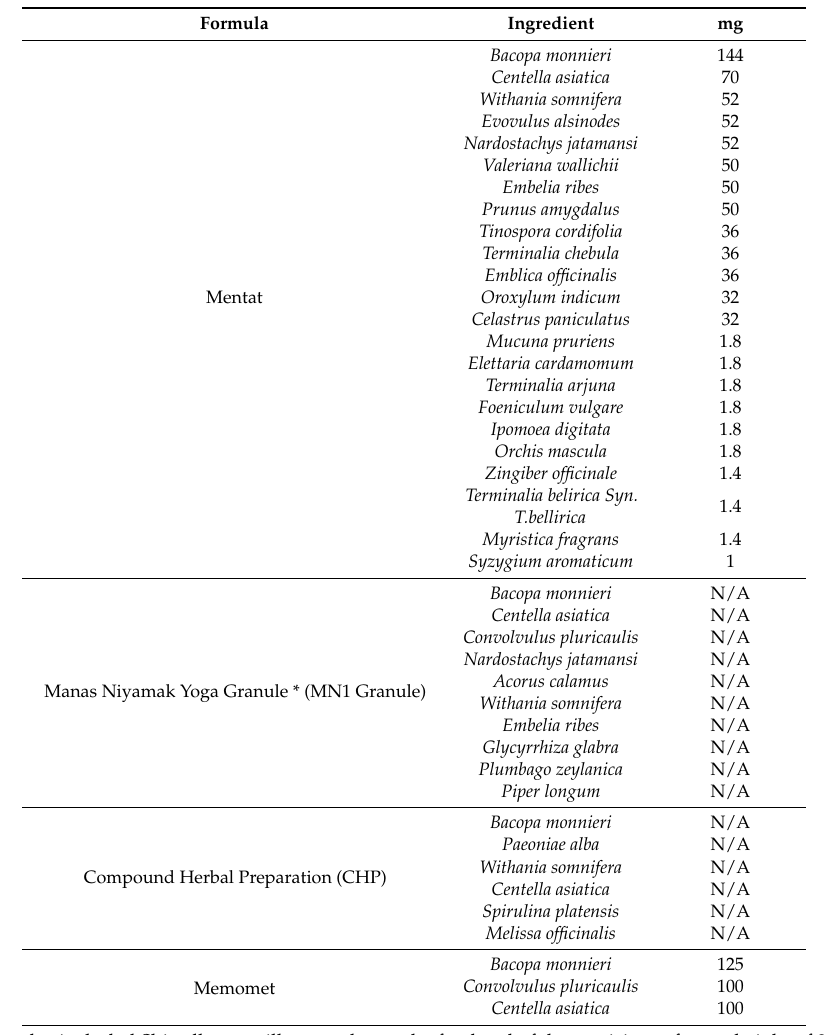
Table 1. Ingredients within each included poly-herbal